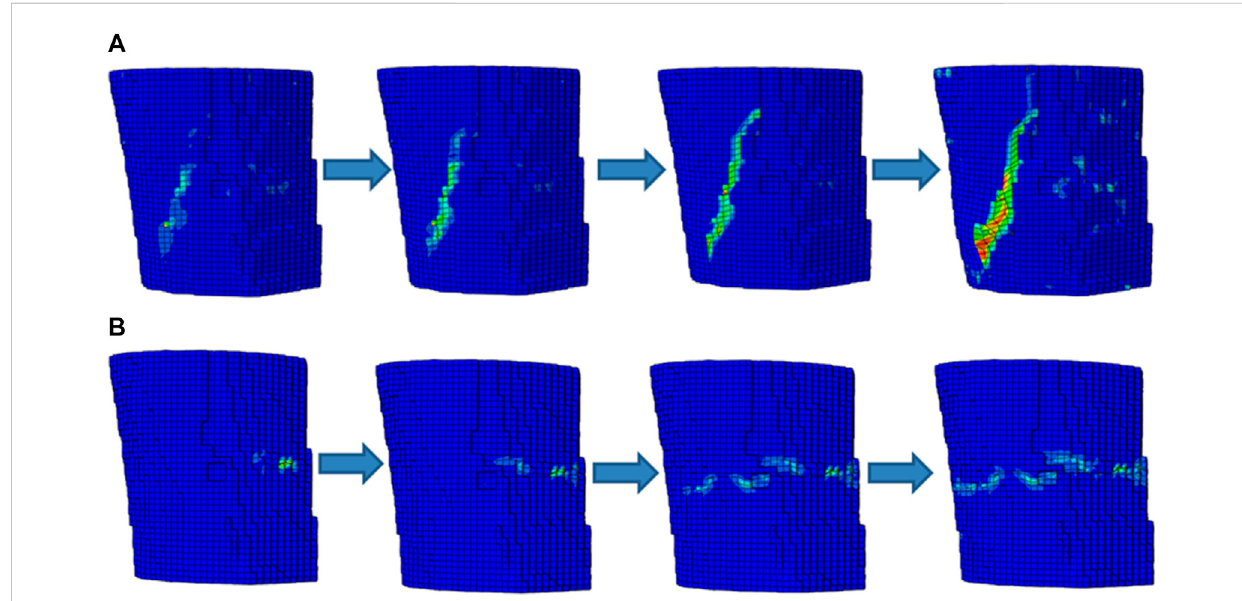
The schematic diagrams of the failure processes in the two simulations (A) Fracture simulation predicted by applying the minimum principal strain; (B) Fracture simulation predicted by applying the equivalent